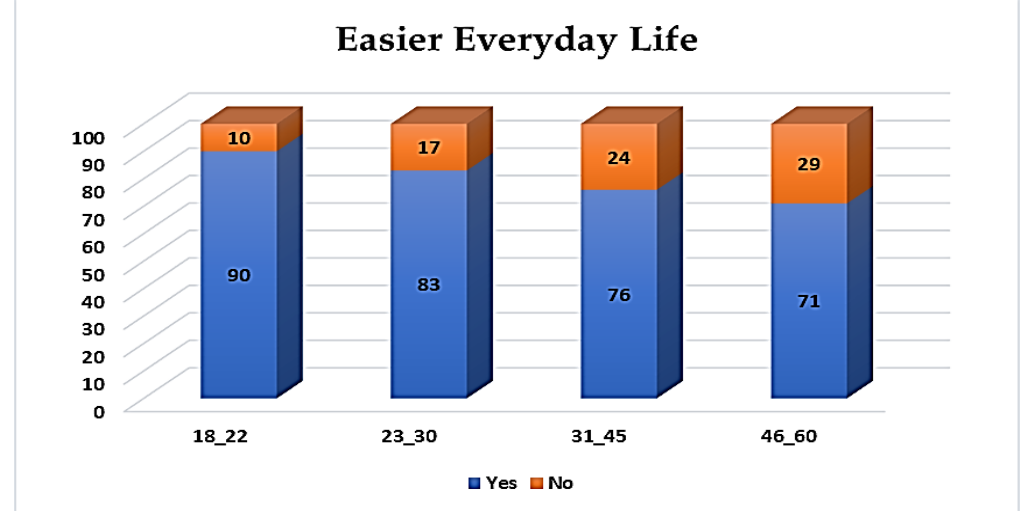
Figure 16. Easier day life due to the BS .